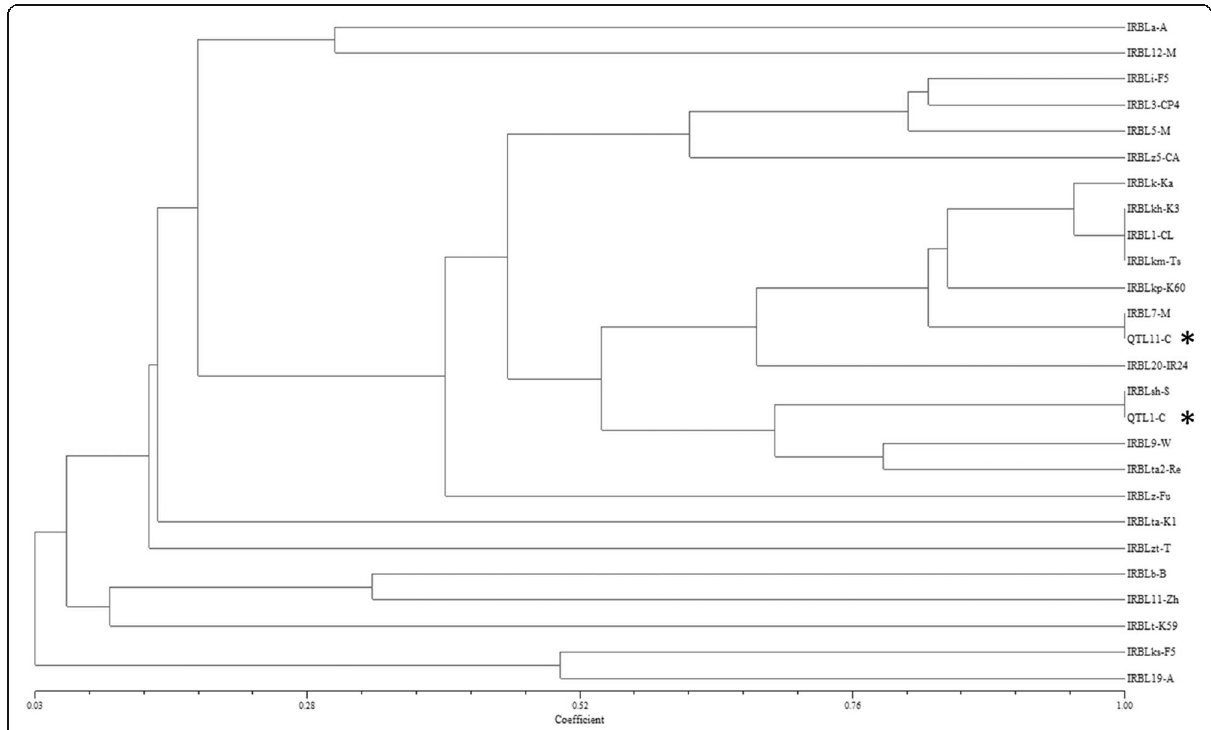
Fig. 3 Cluster analysis of disease reaction patterns of QTL1-C, QTL11-C, and IRBLs against 42 representative blast isolates. The lines of QTL1-C and QTL11-C are highlighted in